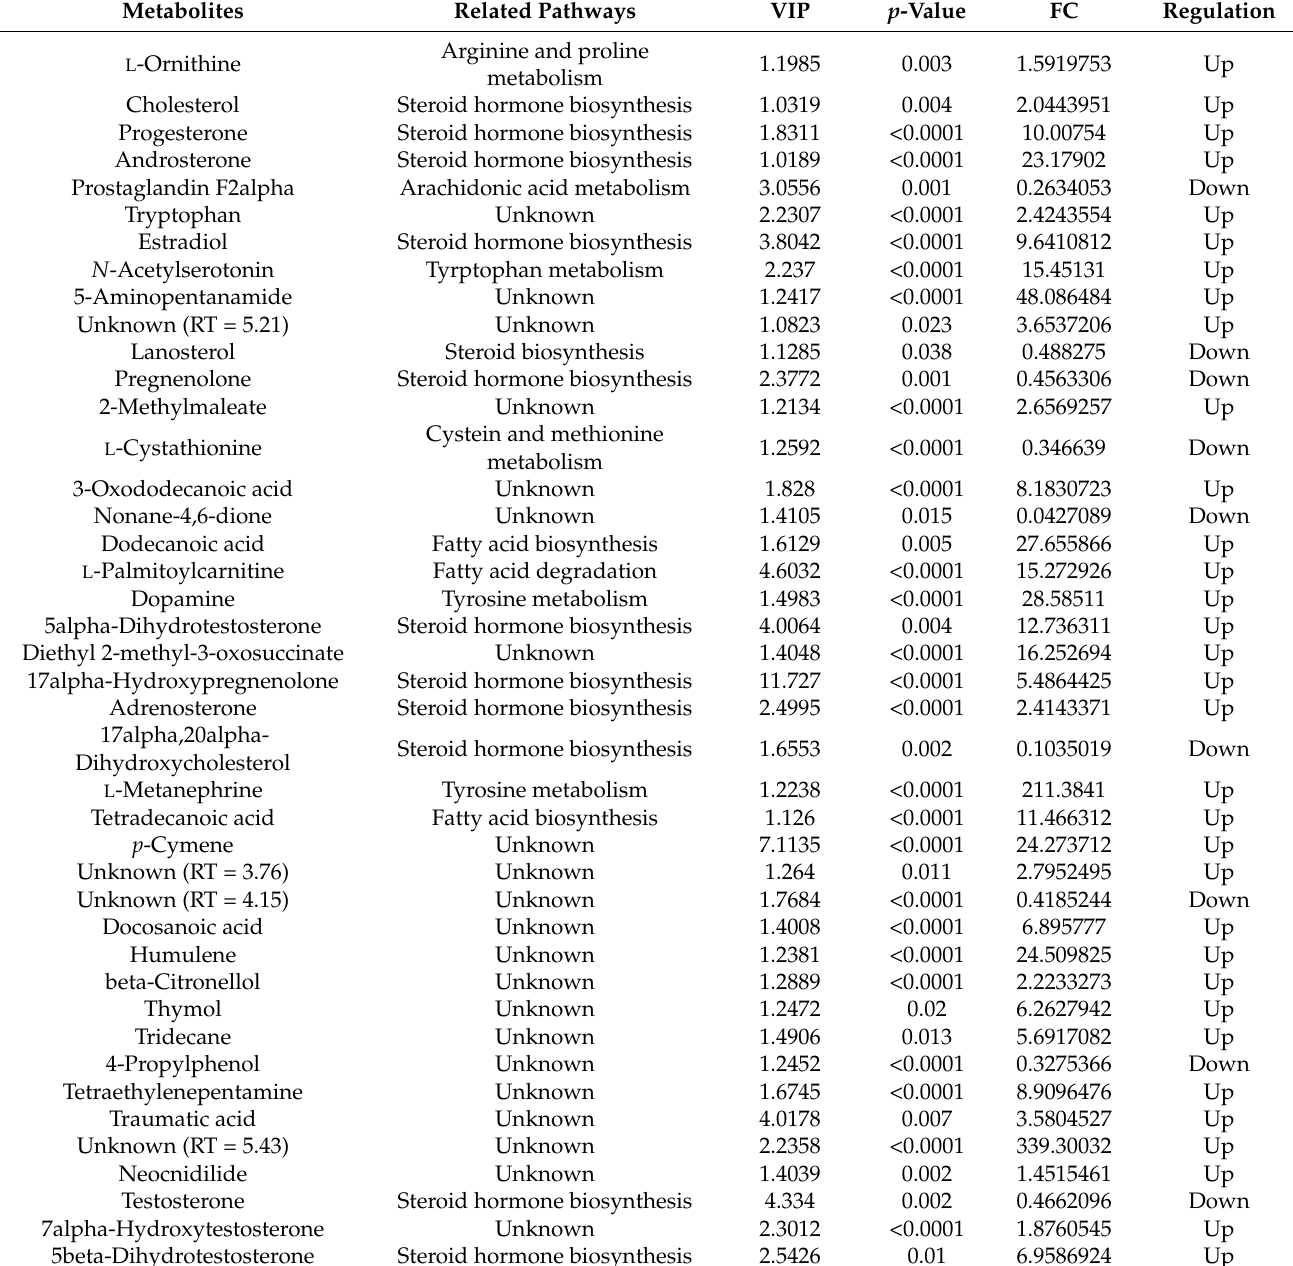
Table 1. Differentially regulated metabolites in patients with pattern baldness and normal controls in male